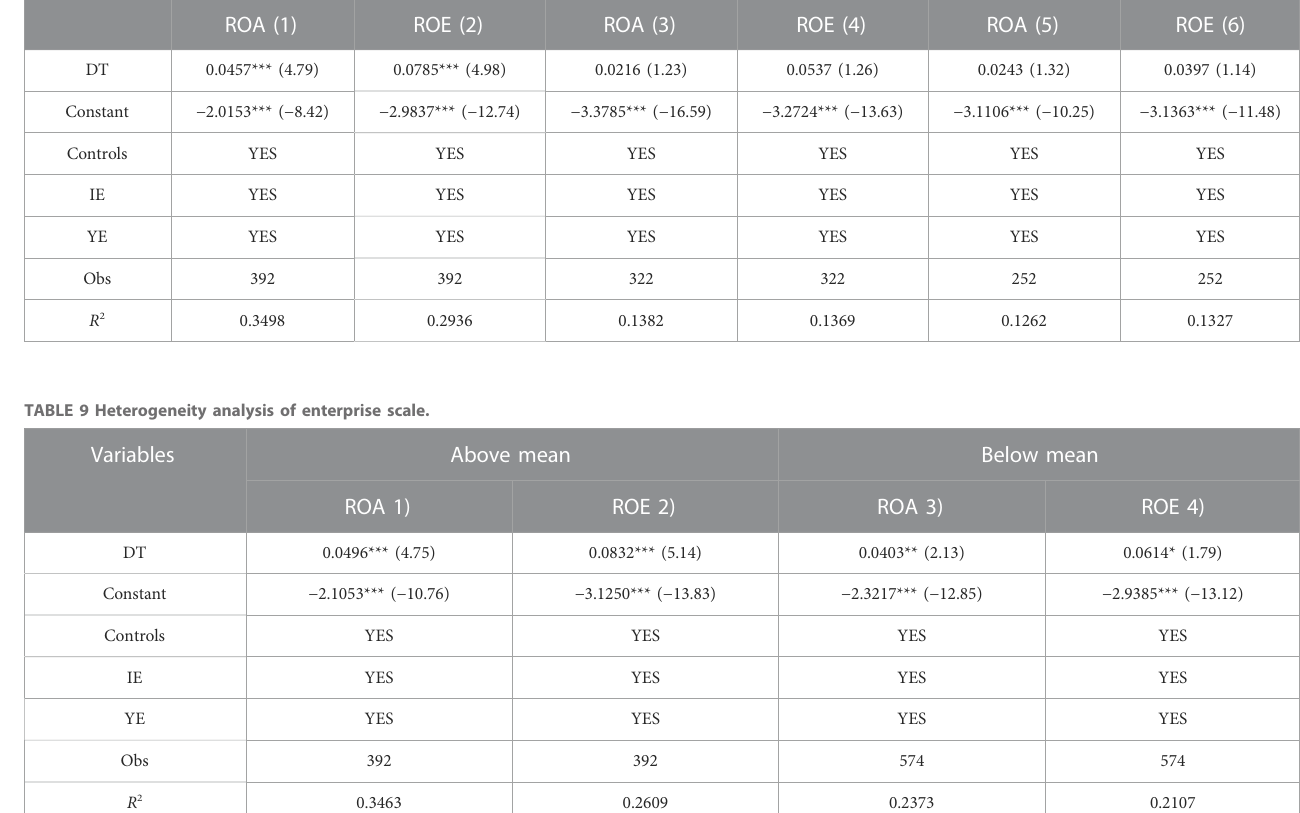
TABLE 8 Heterogeneity analysis of region. Variables